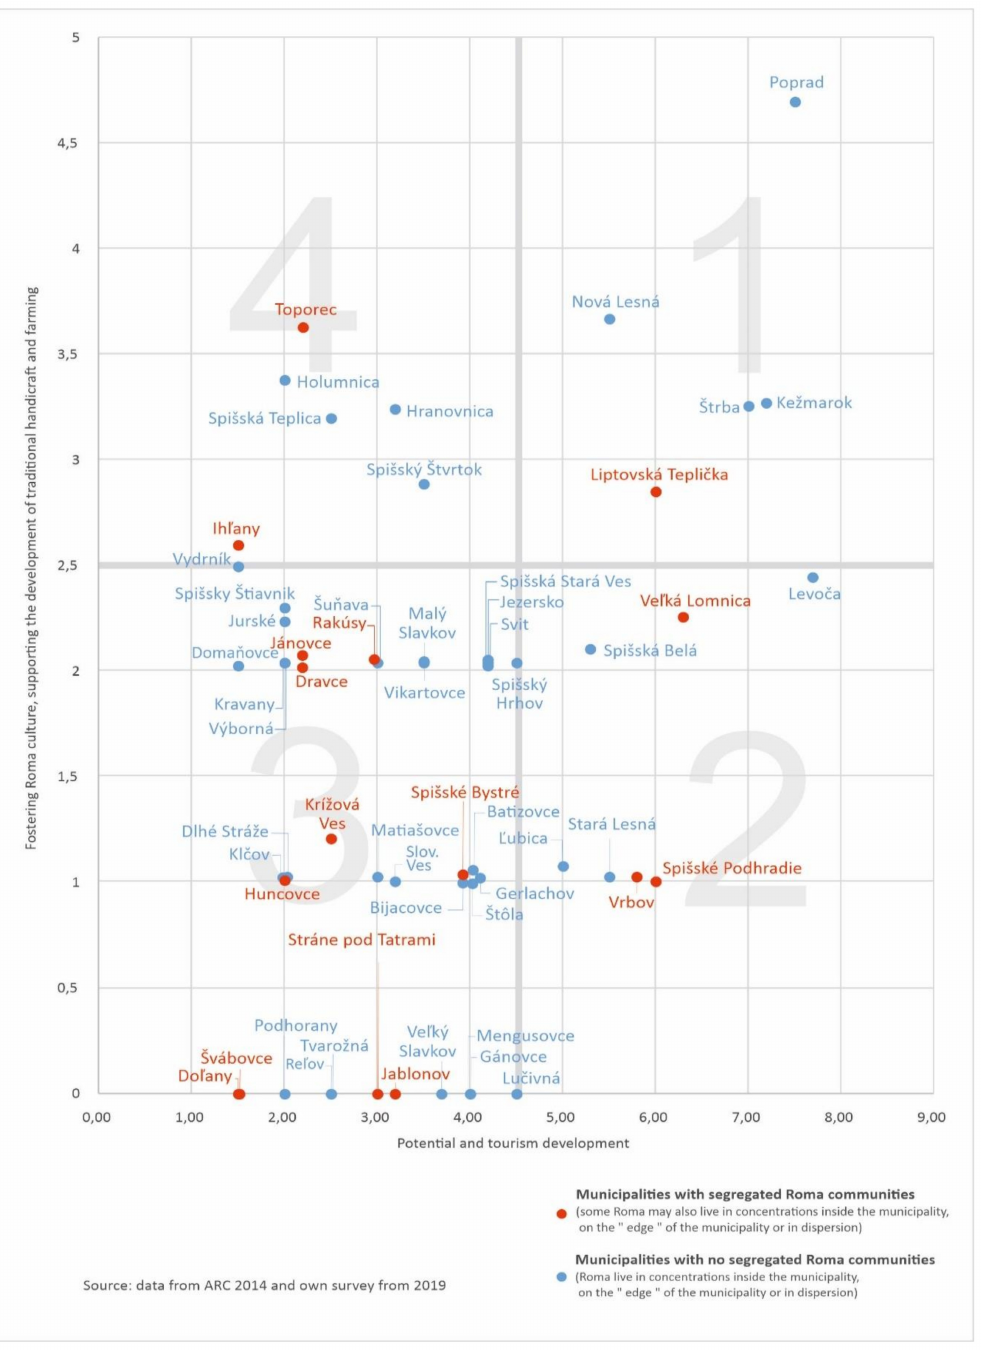
Figure 4. Fostering Roma culture, supporting the development of traditional handicrafts and farming in Central Spiš Municipalities. Source: own evaluation based [45,47] for more see